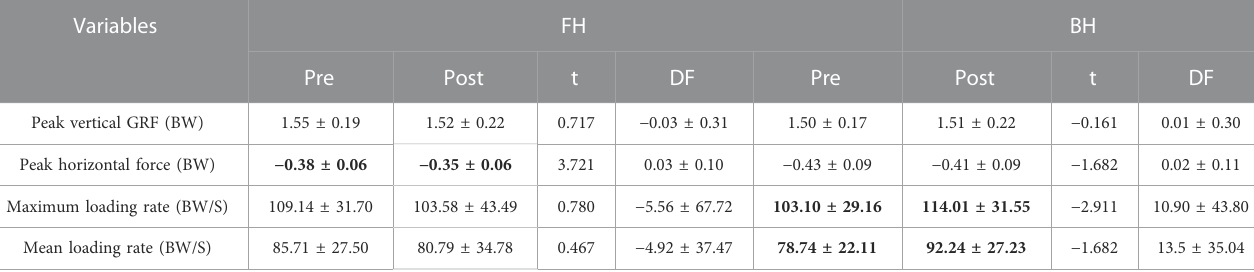
TABLE 2 Comparison of pre-fatigue and post-fatigue means standard deviations for the ground reaction forces (GRFs) characteristics of the FH and BH.